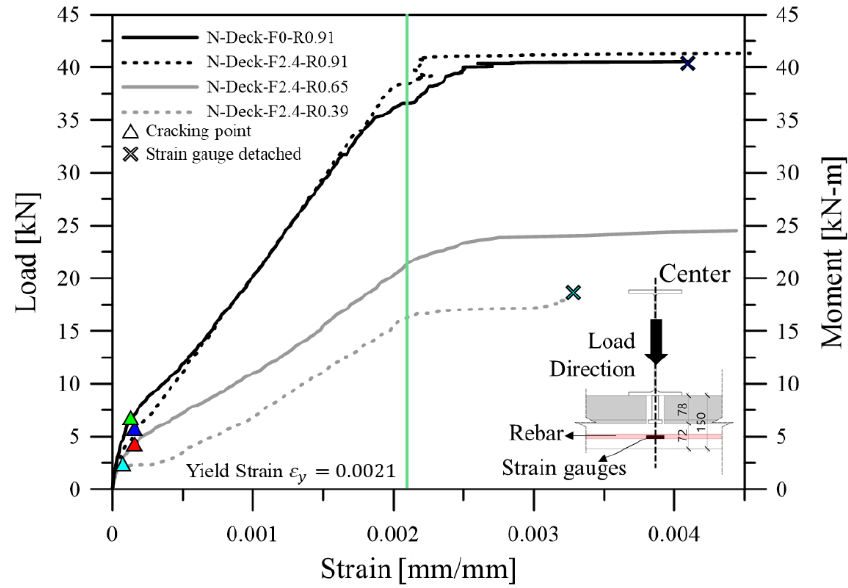
Figure 12. Load–strain relationship (negative moment test specimens; unit: Figure 12. Load – strain relationship (negative moment test specimens; unit: mm).